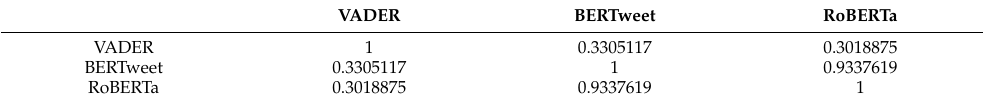
Table 5. Pearson’s correlation coefficients for the positive sentiment polarity. Note the high correla- tions between all of the language models. VADER BERTweet RoBERTa VADER